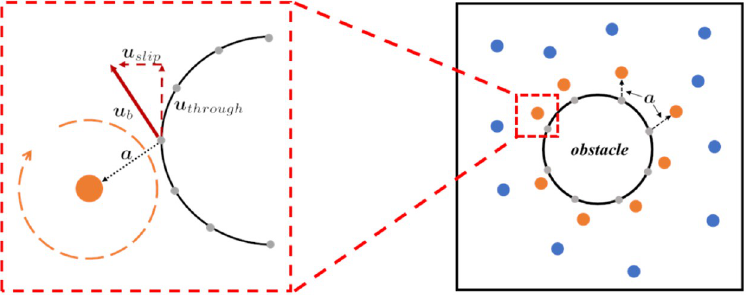
Fig 3. Our boundary treatment method. The gray point is the boundary sampling point; the orange point is the generated vortex particle; v is the induced velocity of flow at the boundary sampling b